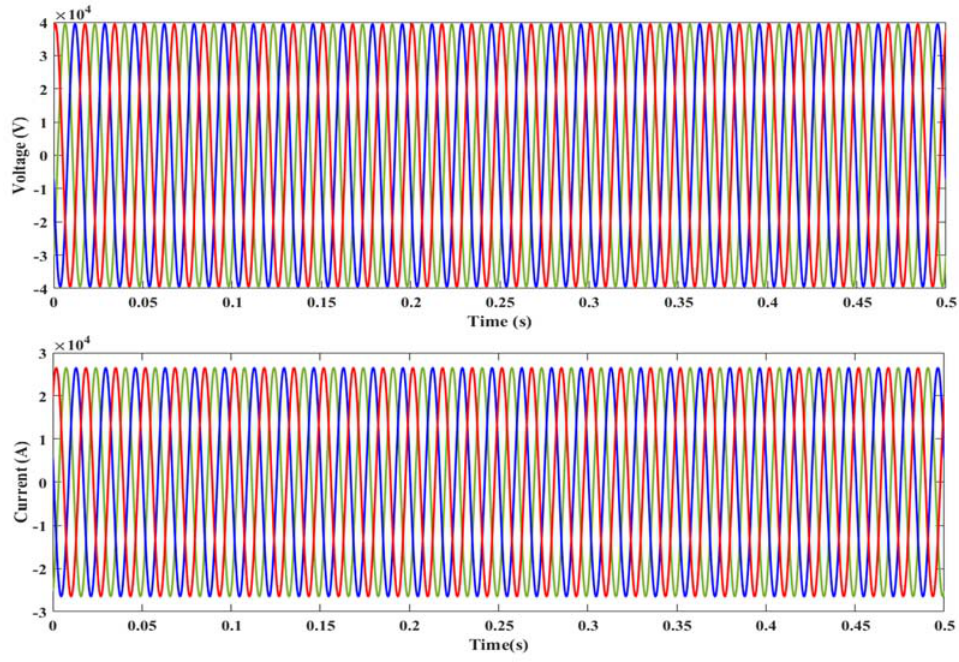
Figure 5. Voltage and current flow under normal conditions at Bus 2.